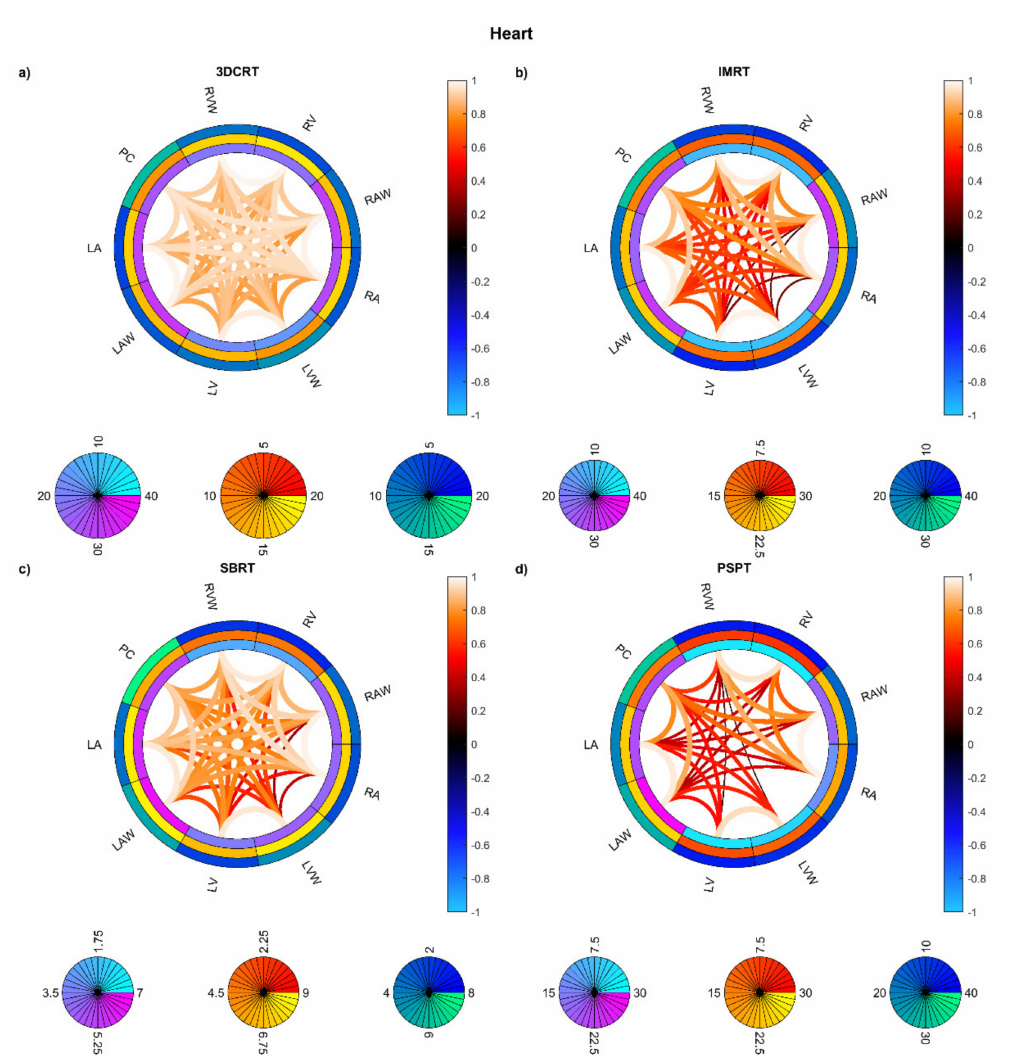
Figure 6. Connectograms in heart substructures for the four groups of patients: Hodgkin lymphoma group—3DCRT ( a ), non-small cell lung cancer patients treated with intensity-modulated radiation therapy—IMRT ( b ), NSCLC patients treated with stereotactic body RT—SBRT ( c ), NSCLC patients treated with passive-scattering proton therapy—PSPT ( d ). The pairwise Spearman correlation coefficients between mean biological effective dose (BED) values to the reported substructures are represented by the lines within the rings. From inside to outside, the rings represent the average of the substructure mean BEDs, standard deviation of the substructure mean BEDs, and average of the dose standard deviations within the substructure. BED is expressed in Gy. Abbreviations: LA: left atrium; LAW: left atrium wall; LV: left ventricle; LVW: left ventricle wall; RA: right atrium; RAW: right atrium wall; RV: right ventricle; RVW: right ventricle wall; PC: